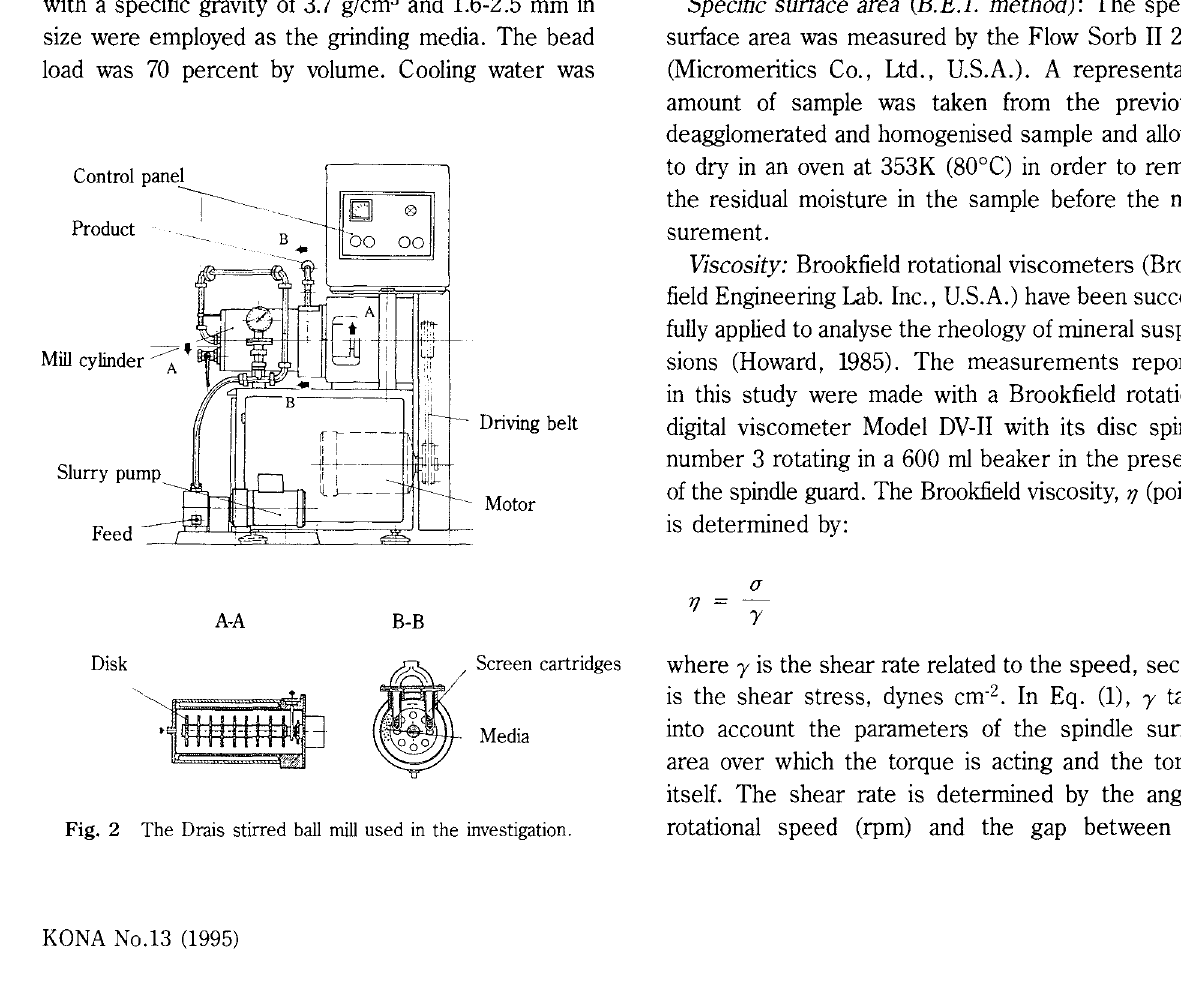
Fig. 2 The Drais stirred ball mill used in the